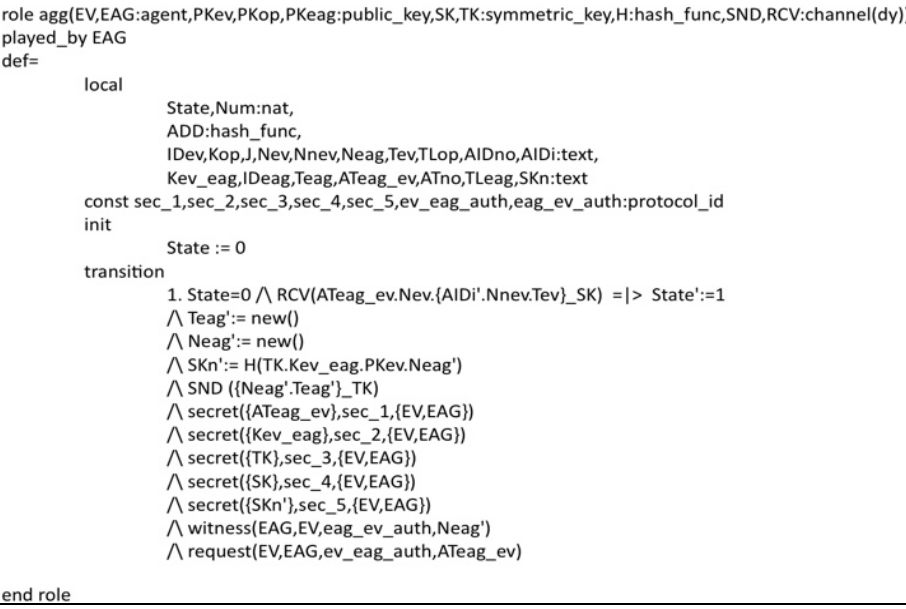
Figure 14. Reauthentication Specification of EAG.